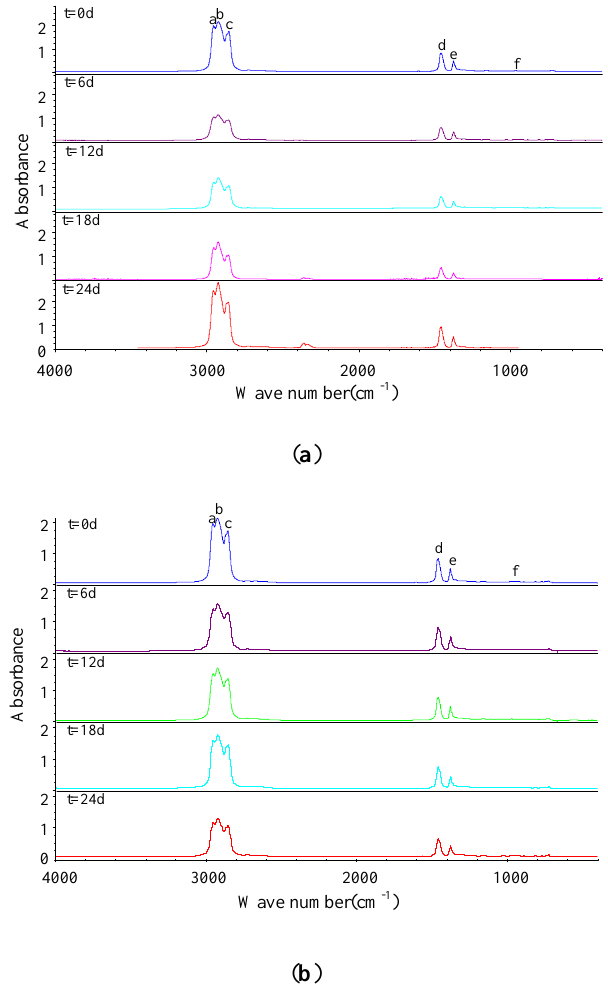
Figure 8. The infrared spectrogram of oil sample containing optical fiber. ( a ) TPEE-containing oil; and ( b ) PTFE-containing oil.